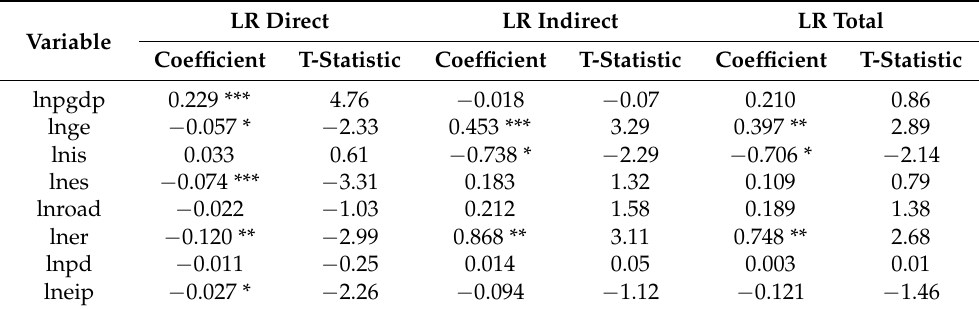
Table 6. Spatial effect decomposition of SDM